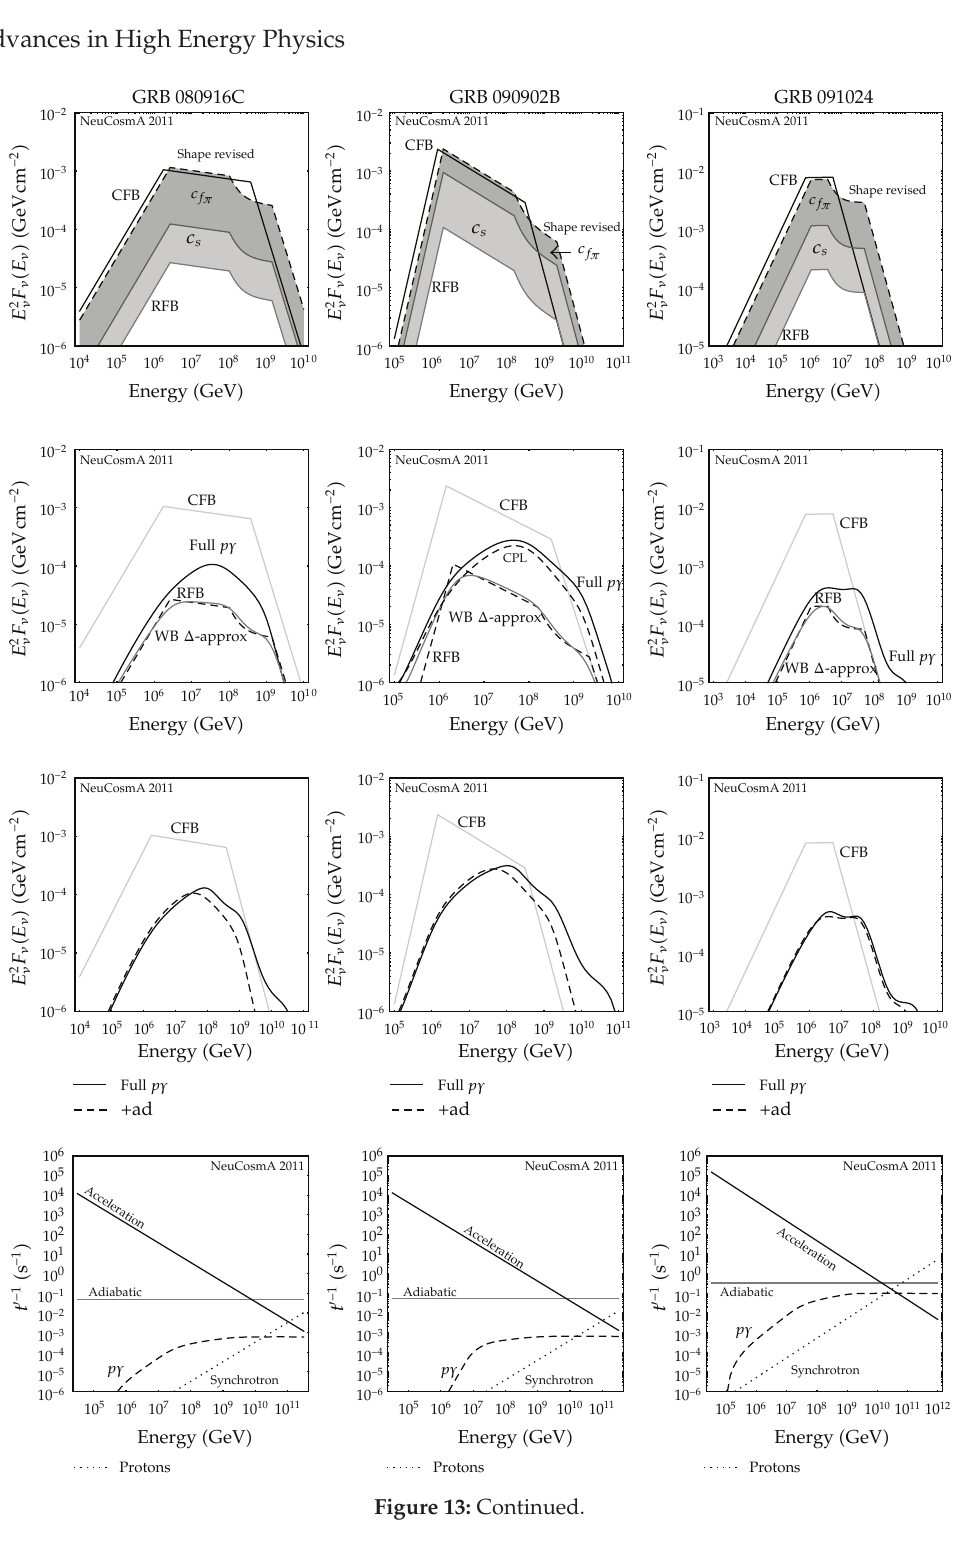
SynchrotronAdiabatic